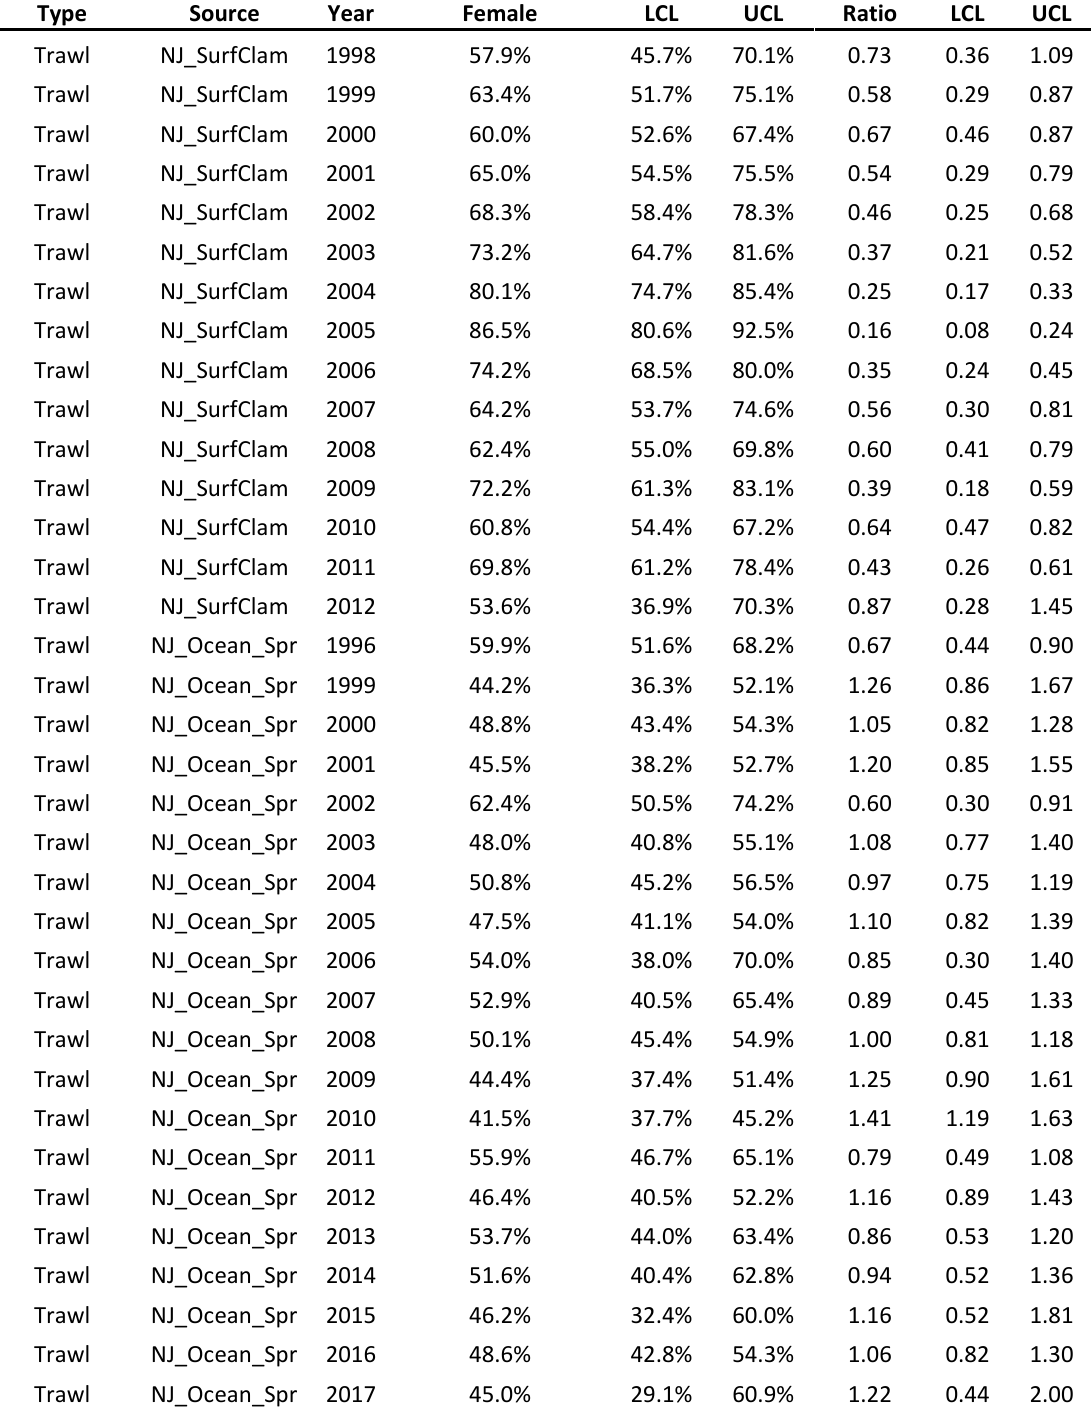
Table 12. Sex ratio and proportion female information, along with associated confidence limits, for each survey of available fisheries-independent and –dependent data